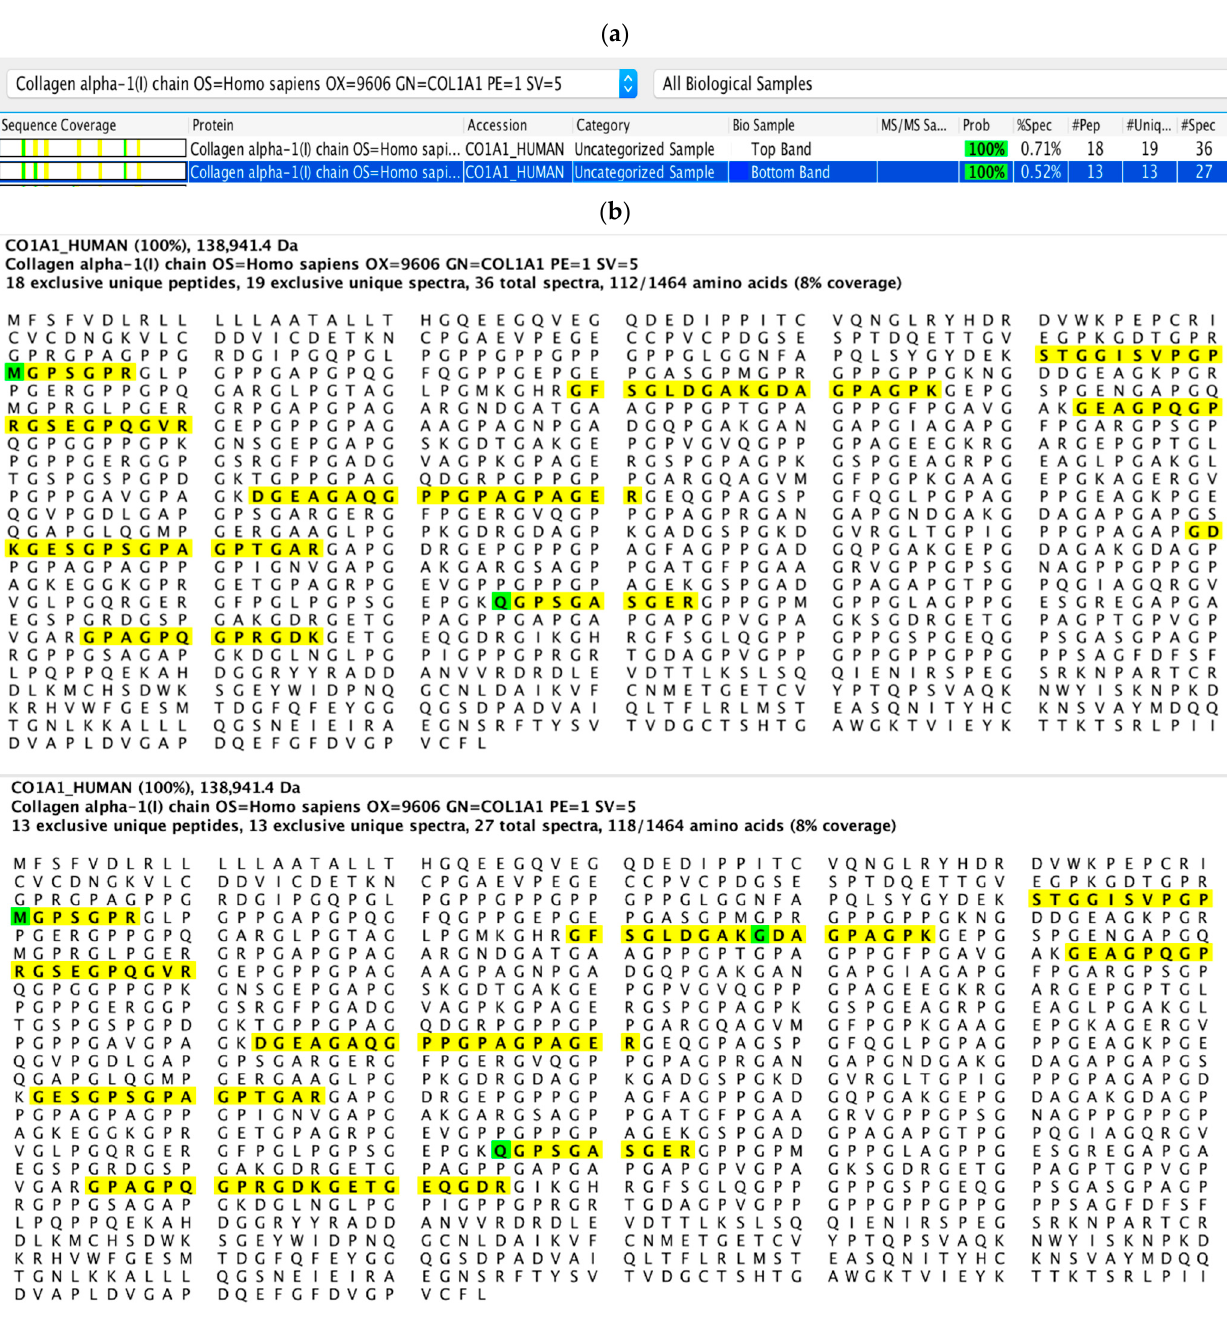
Figure 6. Identification of peptide sequence from dentinal collagen degradation by S. mutans UA159 intracellular proteins. The origin of degraded fragments was identified based on sequence homology against human type I collagen ( a ); peptide sequences were highlighted in sequences of human type I collagen α 1 chain ( b ).